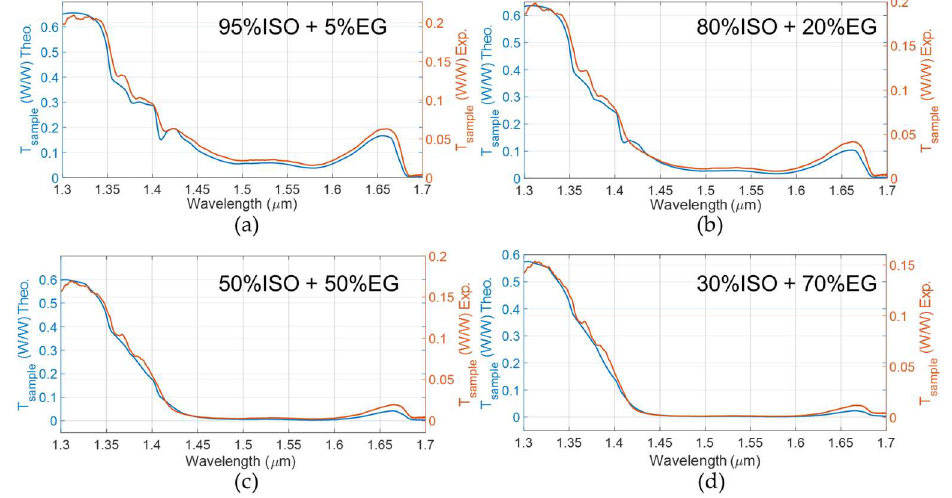
Figure 5. Theoretical (‘Theo.’, blue trace) and experimental (‘Exp.’, orange trace) T sample ( λ ) for solutions of ethylene glycol in isopropanol: ( a ) solution with EG concentration C = 5%; ( b ) solution with EG concentration C = 20%; ( c ) solution with EG concentration C = 50%; ( d ) solution with EG concentration C = 70%. All the theoretical traces of T sample ( λ ) were obtained by applying our developed model using values of extinction coefficients for EG and ISO reported in